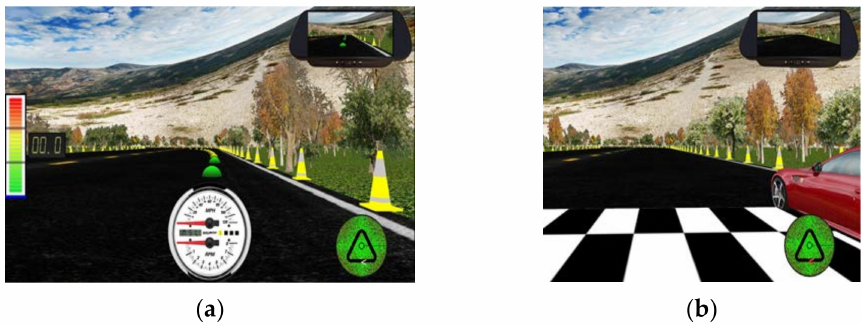
Figure 8. GBL Triple Curve implementation. (( a ) gauge/left vs. ( b ) ghost/right trainers). Table 2. Triple Curve (experiment